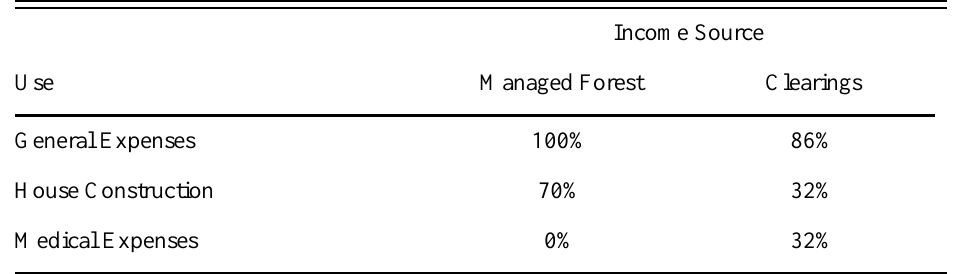
Table 6. Investment of logging